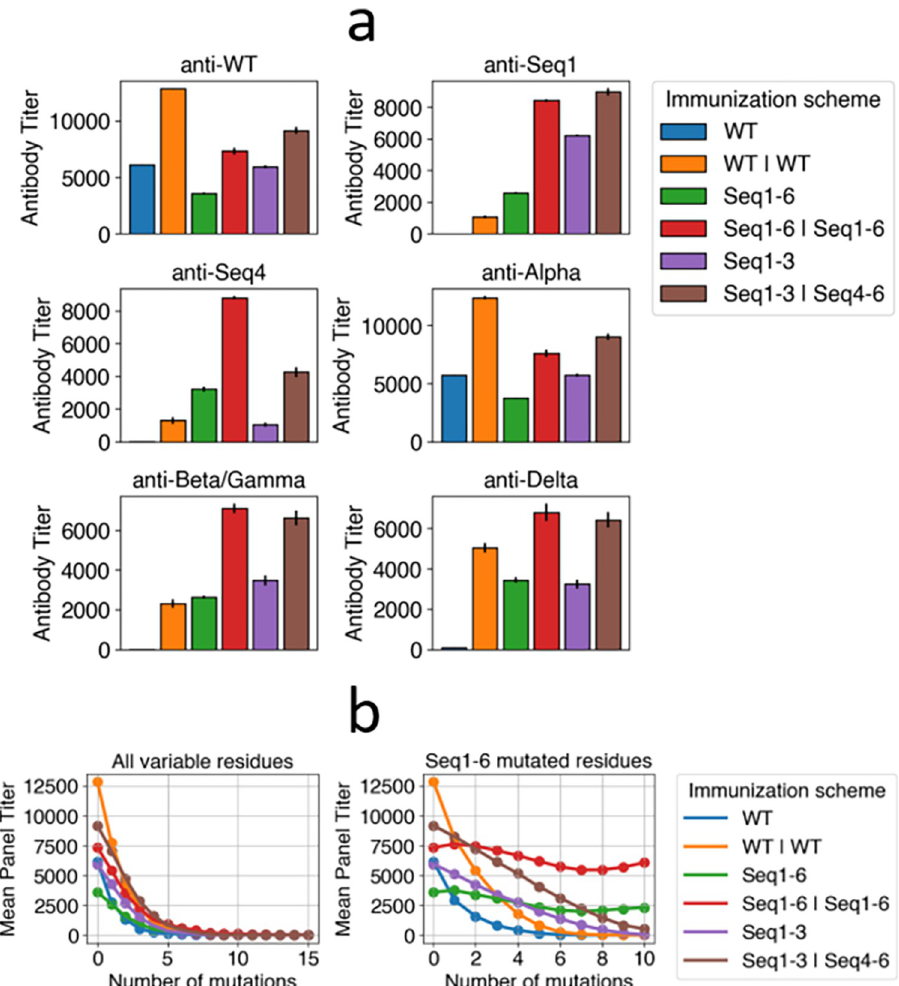
Fig 4. Titers against certain variants are low following WT immunization but high following cocktail immunizations with designed antigens. (a) Titers against WT and variants following different WT or cocktail immunization schemes. Sequences 2 and 3 are similar to sequence 1, so they are omitted for clarity. Sequences 5 and 6 are also omitted because they are similar to sequence 4. Beta and Gamma variants carry biochemically similar RBD mutations, so they are equivalent in this model. (b) Mean panel titers as a function of the number of mutations in panel antigens for different immunization schemes. Two types of panels are considered: one in which panel antigens can be mutated in any variable residue (All variable residues), and one in which panel antigen mutations can only occur in the 10 residues that are also mutated in sequences 1–6 (Seq1-6 mutated residues). It is possible for the panel antigens to have more mutations than in sequences 1–6, which have 5 mutations each. For example, for n = 8, every panel antigen has 8 mutations among the 10 residues that were mutated in the designed